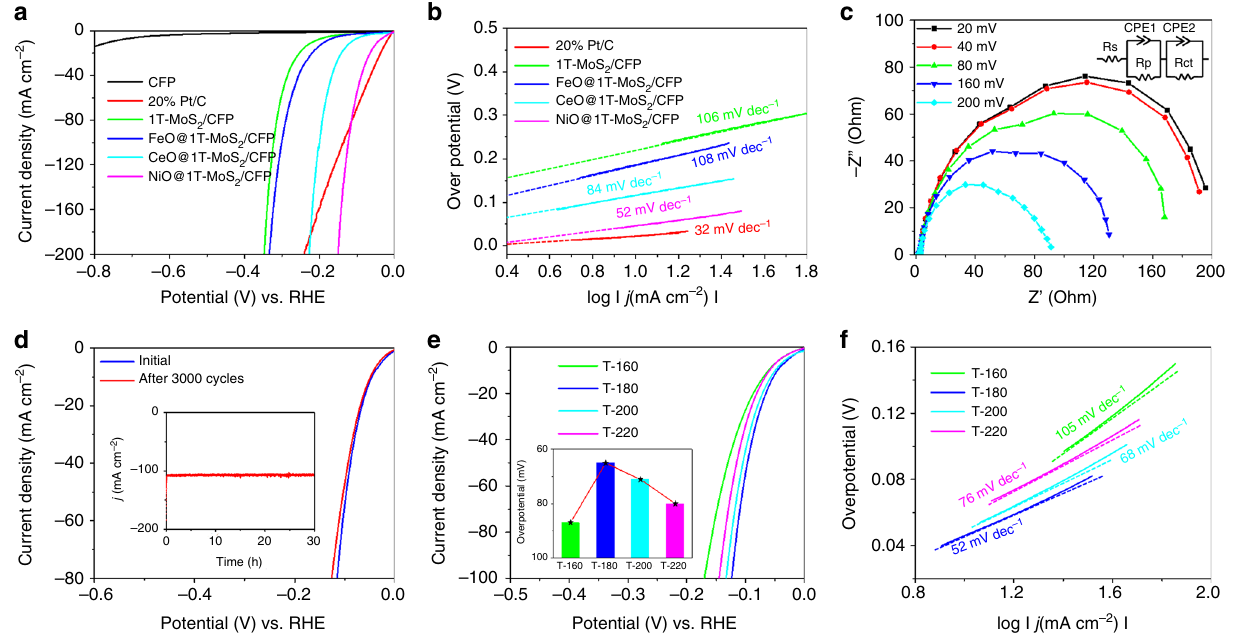
Fig. 5 HER catalytic performances and EIS responses for NiO@1T-MoS 2 . a Polarization curve of all catalysts in 1.0M KOH (scan rate: 5mVs − 1 under a three- electrode con fi guration). b Tafel plots. c Electrochemical impedance spectroscopy (EIS) of NiO@1T-MoS 2 at various overpotentials. d Stability tests of NiO@1T- MoS 2 (inset: the long-term durability tests at η = 130mV for 30h). e Polarization curves (inset: overpotentials to drive 20mAcm − 2 ). f The corresponding